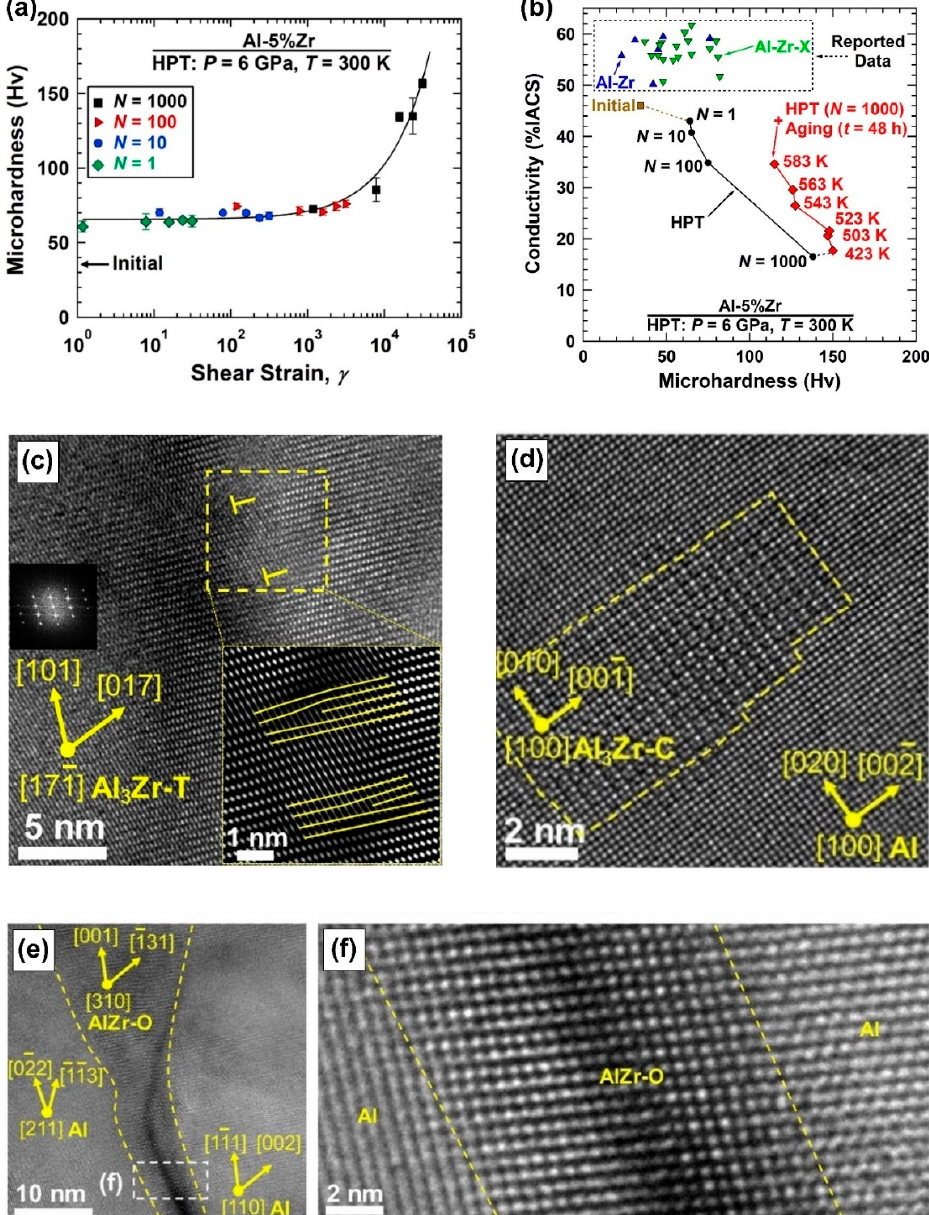
Figure 2. Age hardening and high thermal stability in immiscible Al-Zr alloy after ultra-SPD. ( a ) Hardness against shear strain after ultra-SPD through various HPT rotations. ( b ) Electrical conductivity versus hardness after ultra-SPD and aging for 48 h at different temperatures compared to data reported for conventional SPD-processed binary and ternary Al-Zr alloys. Lattice images of ( c ) Al 3 Zr intermetallic with tetragonal structure, ( d ) Al 3 Zr with cubic structure precipitated in aluminum matrix after aging, and ( e , f ) AlZr with orthorhombic structure formed at aluminum grain boundaries, where ( f ) is magnified view of rectangular region in ( e )